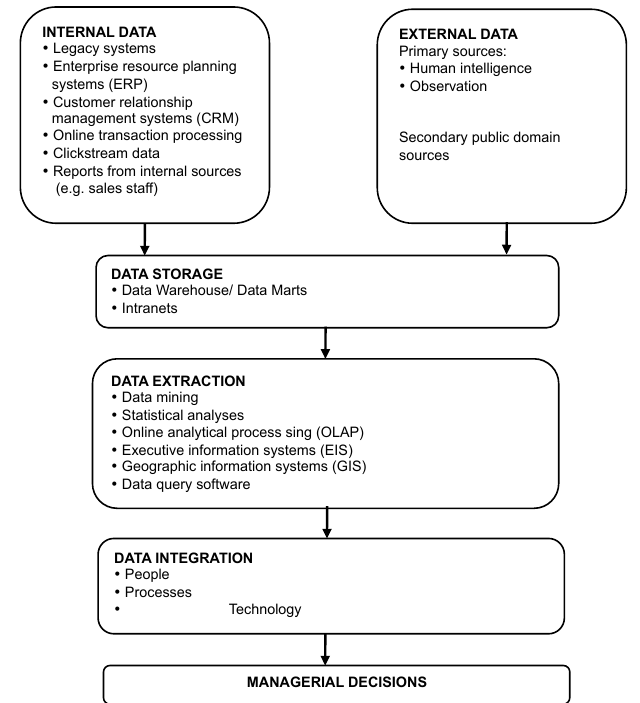
A theoretical framework of the MI